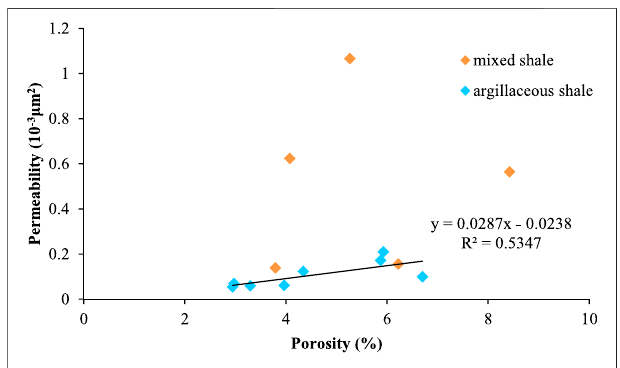
FIGURE 5 | Intersection diagram of porosity and